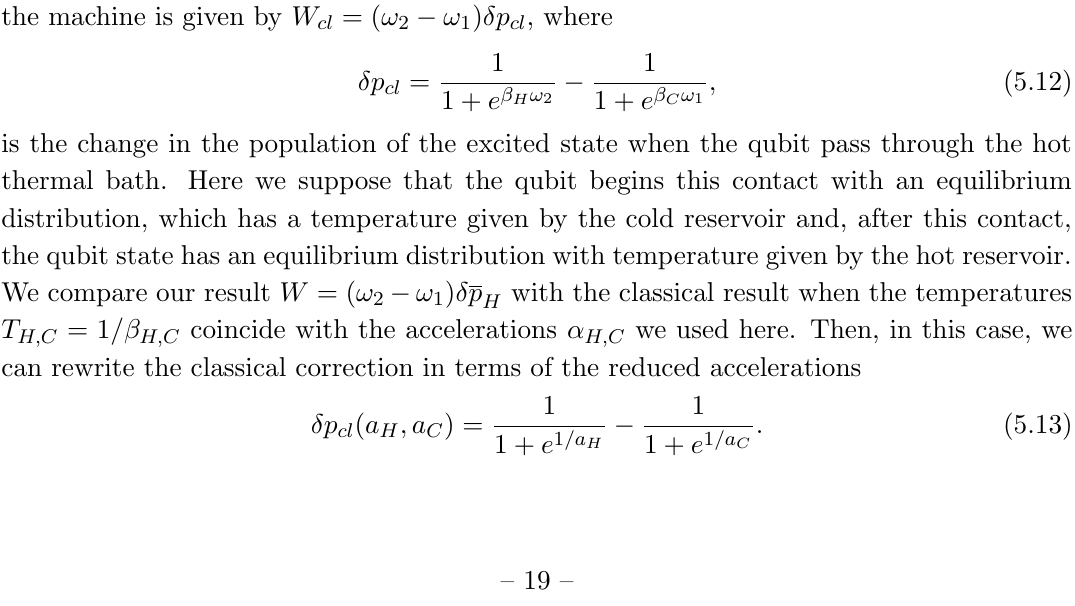
accelerations a H and a C . We get positive heat from the quantum vacuum (cid:14)p a H > a C